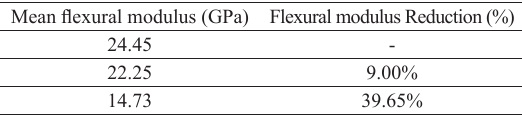
Table 4. Flexural modulus of the thermoplastic composites with